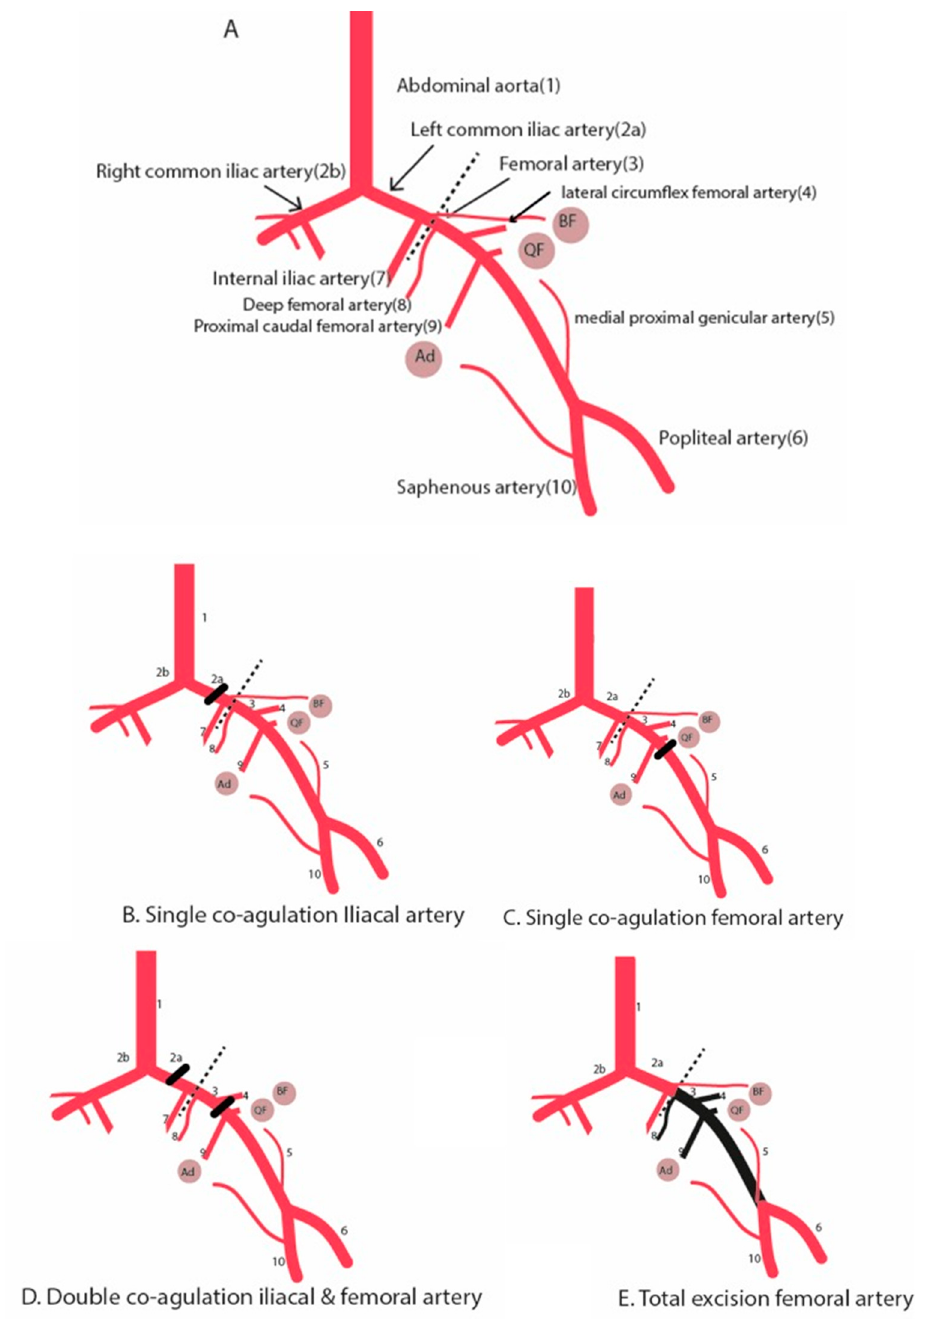
Figure 1. Schematic diagram illustrating the hind limb ischemia and different surgical methods to induce hind limb ischemia. ( A ) Hind limb vasculature. ( B ) Single electrocoagulation of the iliac artery. ( C ) Single electrocoagulation of the femoral artery. ( D ) Double electrocoagulation of the iliac and femoral artery. Alternatively, the electrocoagulation of the iliac artery can be replaced by a second electrocoagulation of the femoral artery just above the bifurcation of the saphenous and popliteal artery. ( E ) Total excision of the femoral artery. Round circles are muscle groups: (Ad) adductor muscle group. (QF) Quadriceps femoris. (BF) Biceps femoris. Dotted line is the inguinal ligament. Black beam is the occlusion site.